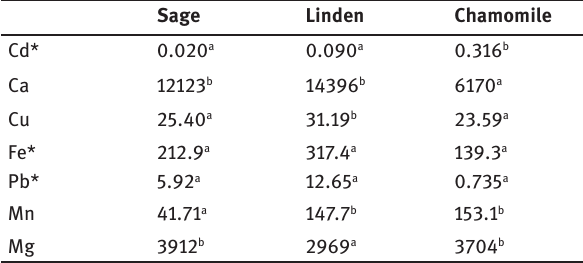
Table 6: Results of statistical comparison among sage, linden and chamomile with respect to content of Cd, Ca, Cu, Fe, Pb, Mn and Mg, expressed in mg kg -1 . Means with the same letter are similar at P =0.05 level of significance.